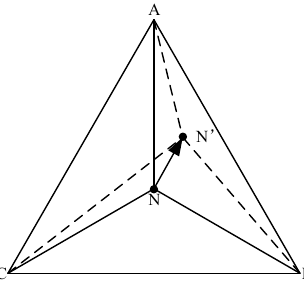
Figure 1. Three-phase four-wire distribution system. In the LVDN, voltage shift or displacement occurs when imbalance exists. The sche- In the LVDN, voltage shift or displacement occurs when imbalance exists. The matic diagram of voltage neutral-point displacement is depicted in Figure 2. schematic diagram of voltage neutral-point displacement is depicted in Figure 2.